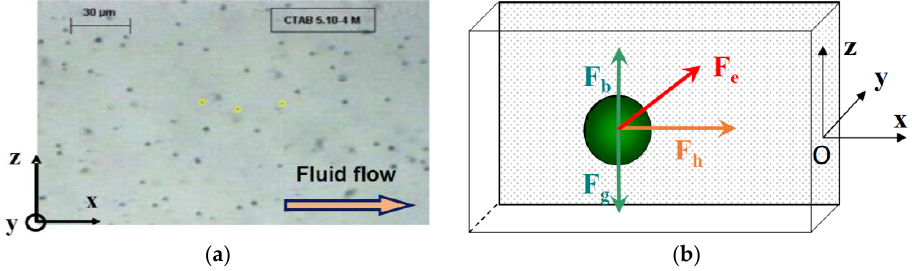
Figure 2. ( a ) Front view of the cathode, dark points are particles near the electrode; ( b ) External forces acting on a particle in the EPD laminar flow cell.